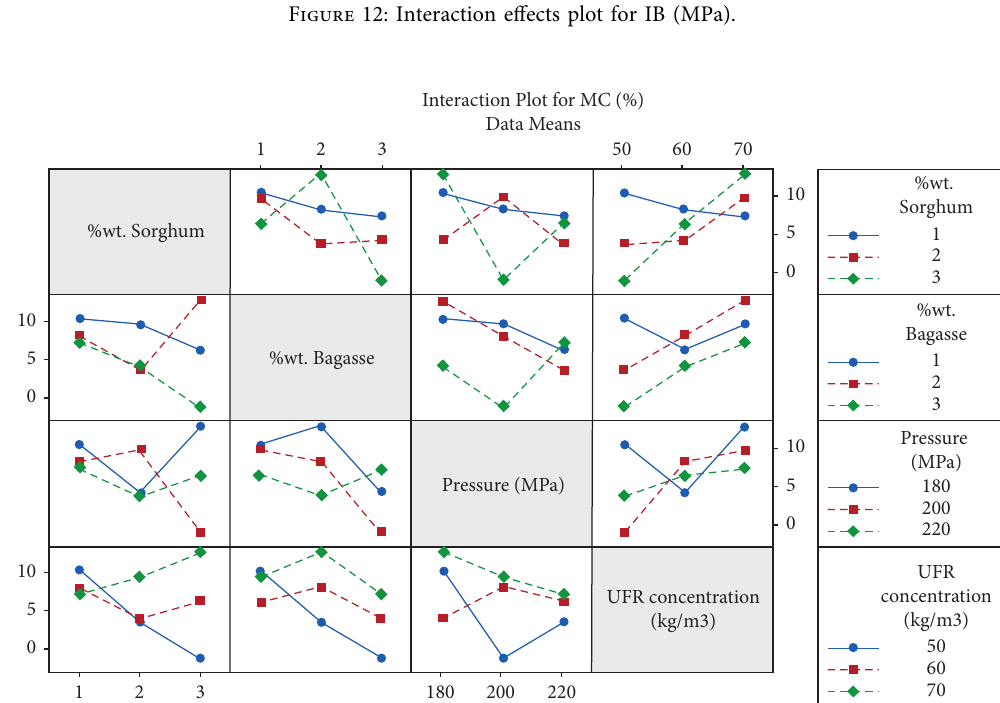
Figure 13: Interaction effects plot for